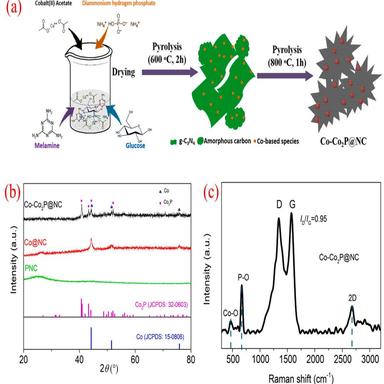
(a) The schematic synthetic procedure of the preparation process of Co-Co2P @ NC; (b) XRD patterns and (c) Raman spectrum of Co-Co2P @ NC.